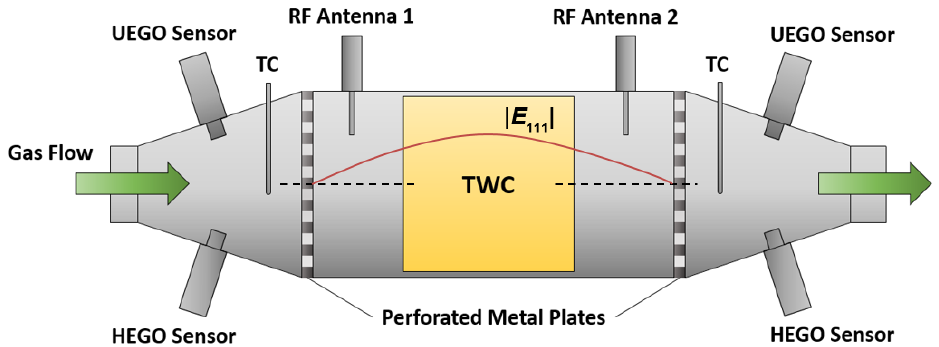
Figure 1. Setup of the cavity resonator for catalyst experiments.